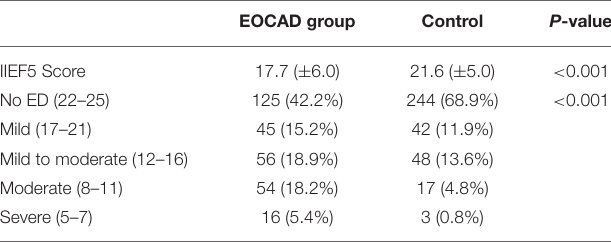
P-values were estimated from t-test for continuous variables and Chi-square test for categorical